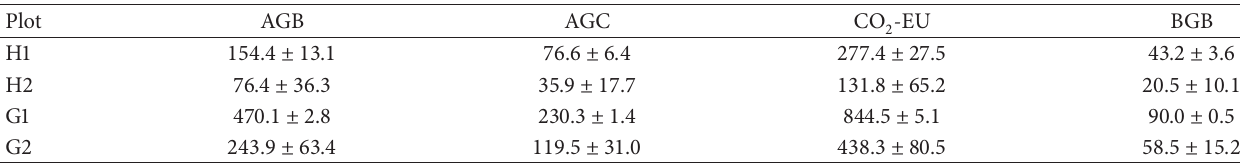
Table 2: Tree-based estimator average values and standard deviations calculated for the forest subtypes in the present study. All values are given in megagrams per hectare. Plot AGB